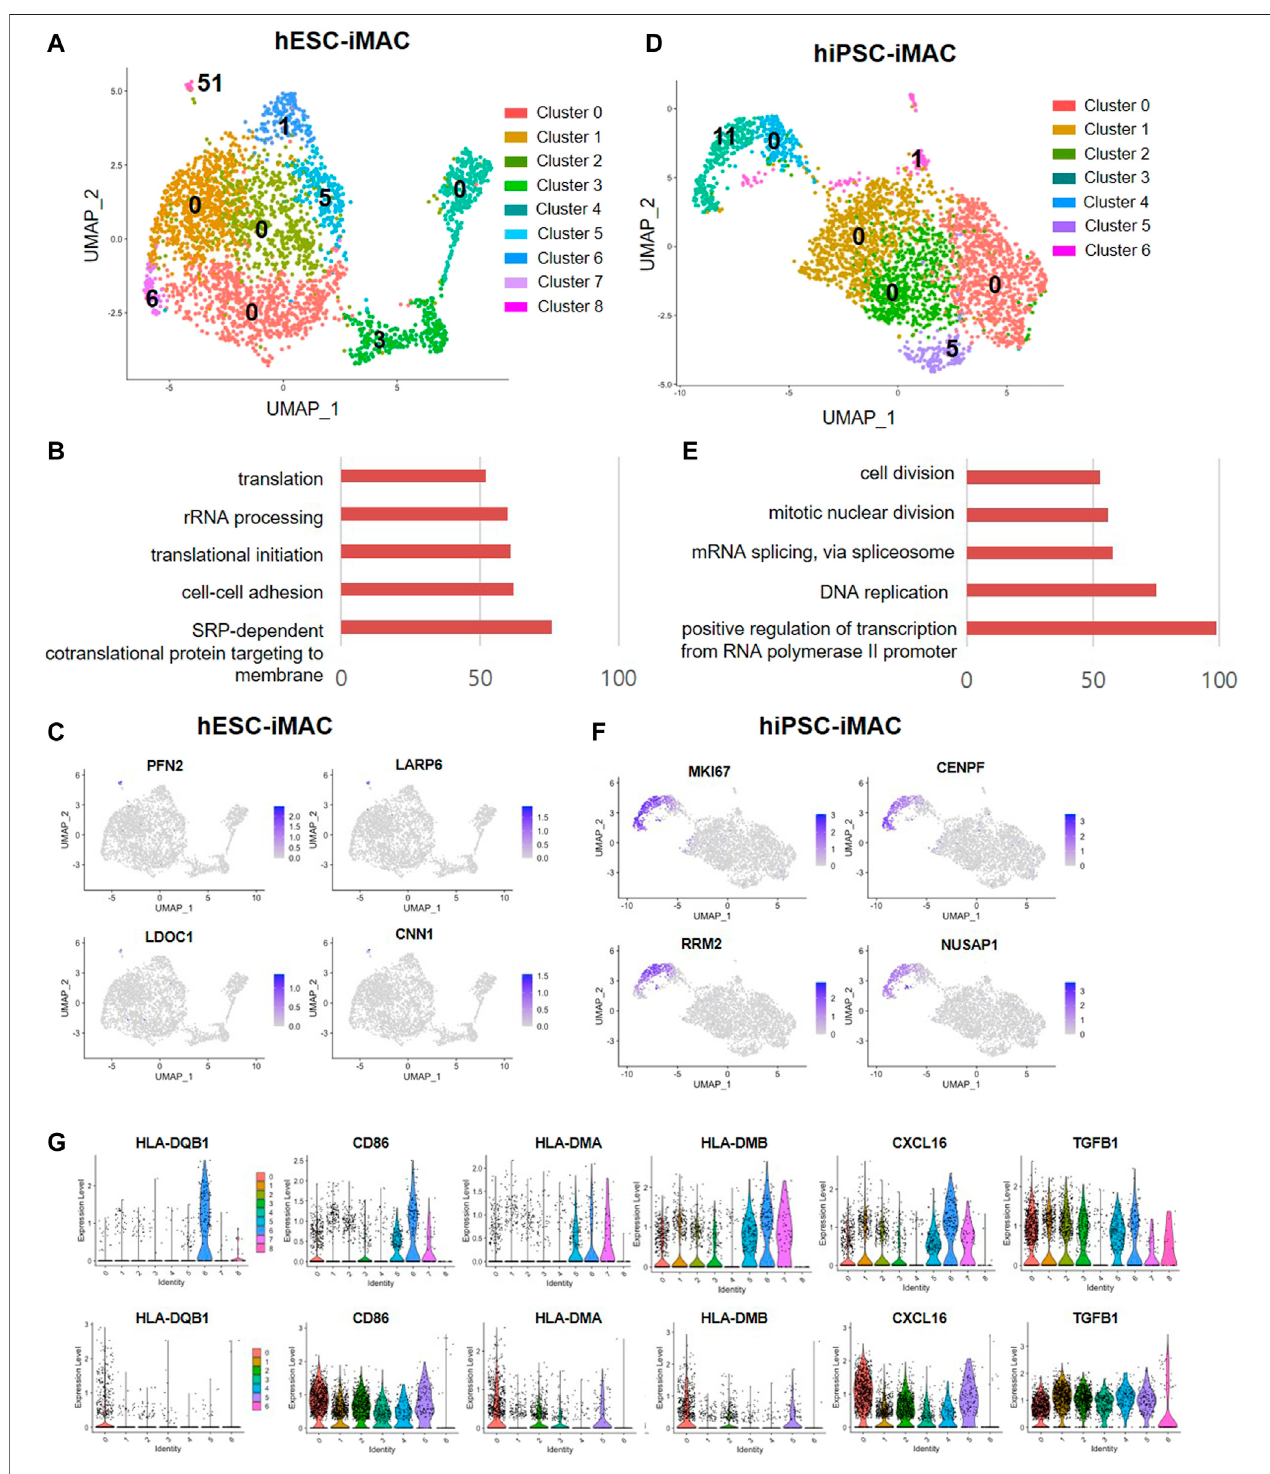
FIGURE 4 | Differentially expressed genes and M1 and M2 macrophage marker genes in iMACs. (A) Number of DEGs of each cluster (Log2 fold change > 2, p < 0.05, exclude mitochondrial genes) in hESC-iMAC. (B) Gene ontology (GO) analysis of DEGs in cluster 8 (hESC-iMAC) (GO FDR < 0.05, DEG count > 10, Top 5) (C) UMAP plotsfortheexpression ofthetop4genesincluster8ofhESC-iMAC. (D) NumberofDEGsofeach cluster(Log2foldchange > 2, p < 0.05, excludemitochondrial genes) in hiPSC-iMAC. (E) Gene ontology (GO) analysis of DEGs in cluster 3 (hiPSC-iMAC) (GO FDR < 0.05, DEG count > 10, Top 5). (F) UMAP plots for the expression of the top 4 genes in cluster 3 of hiPSC-iMAC. (G) Gene expression of M1 and M2 macrophage markers in each cluster.